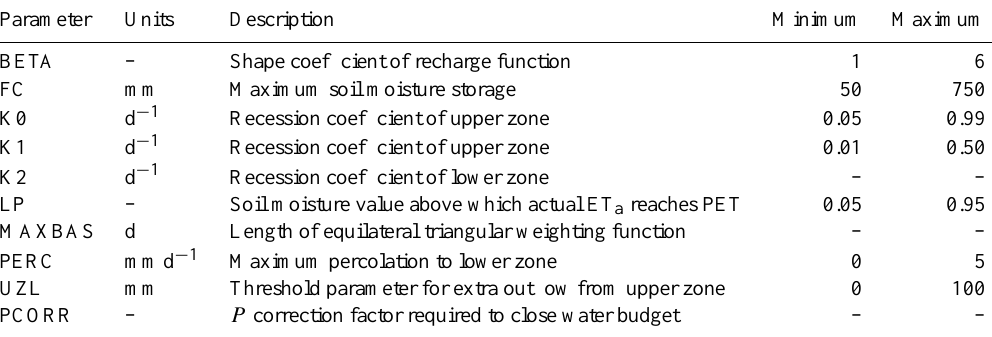
Table 3. HBV-light model parameter units, descriptions, and ranges used for the calibration. The K2 and MAXBAS parameters were not calibrated, but were set to 1 − k bf (cf. Table 1) and one, respectively. For the Valenciano, Can´ovanas, Grande de Patillas, and Culebrinas catchments calibration ranges of 1.2–1.3, 0.7–0.8, 1.4–1.5, and 1.4–1.5, respectively, were used for PCORR. For the remaining eight catch- ments PCORR was set to